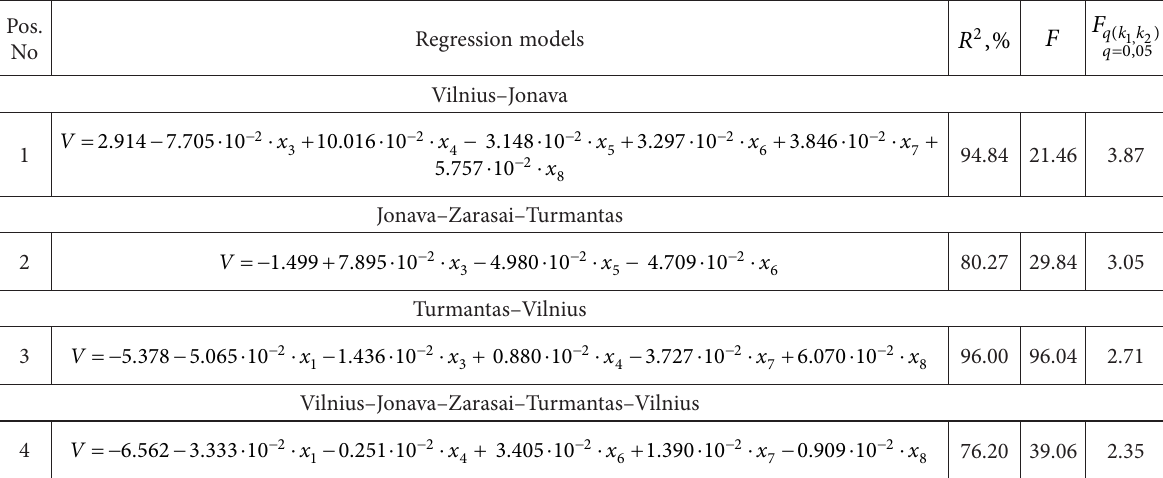
Table 3 . Results of the regression analysis Regression